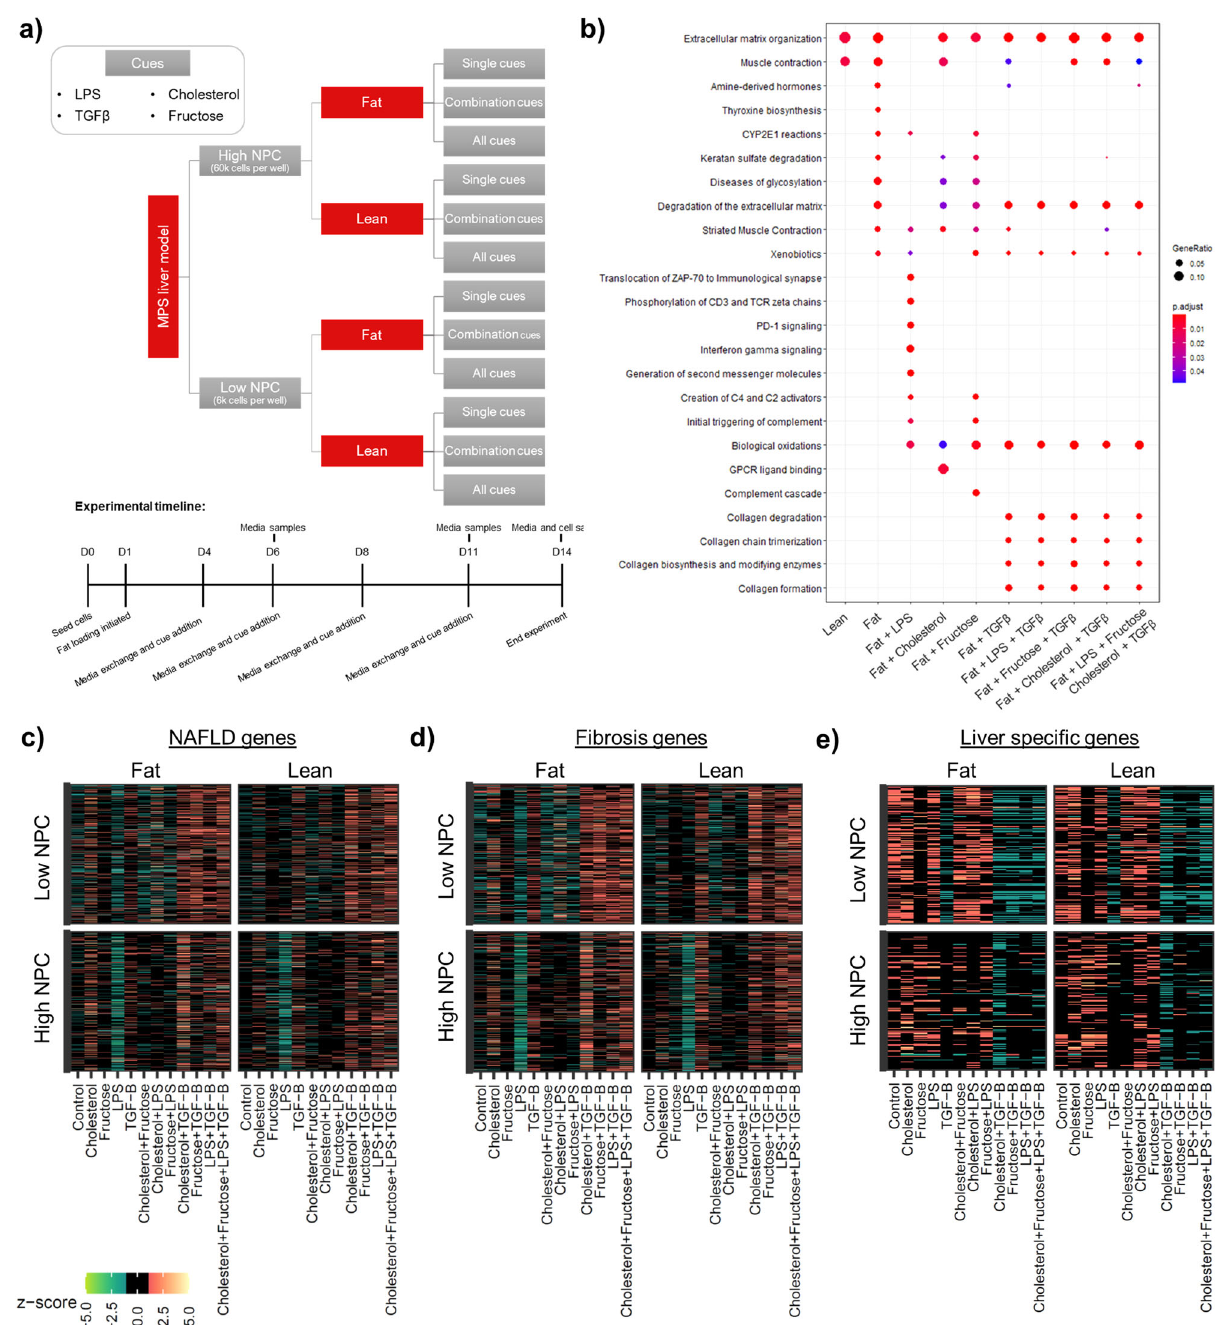
Fig. 4 Systems biology interrogation of liver MPS NASH model to determine physiologically relevant cues that promote transcriptional changes to mimic advanced NASH disease state. PHH, KC and HSC co-cultures were cultured in the MPS platform under a variety of conditions for 14 days and transcriptomic pro fi le of microtissues were compared. a Study was designed to test number of NPCs, presence of fat, fructose, cholesterol, LPS and TGF β for effects on the transcriptional pro fi le of the liver MPS NASH model. b Differentially expressed genes (de fi ned by comparison to low NPC lean) from selected conditions were compared to identify enriched pathways and biological processes, using PANTHER database and mapped using CompareCluster, with size of cluster representing number of genes involved (GeneRatio) and colour identifying con fi dence interval (p.adjust). Only high NPC conditions shown (low NPC data in Supp. Fig. 8) and some conditions did not produce any gene clusters with signi fi cant p value < 0.05 and are not shown on plot. c Expression of markers of NAFLD activity score progression 45 . d Expression of markers of fi brosis stage progression in NAFLD 45 . e Expression of liver- speci fi c genes 46 . Heat maps used to compare different culture conditions with data normalised to z-scores to show variance from mean of all observations for each gene. Transcriptomic data were generated from a minimum of three independent replicate samples per